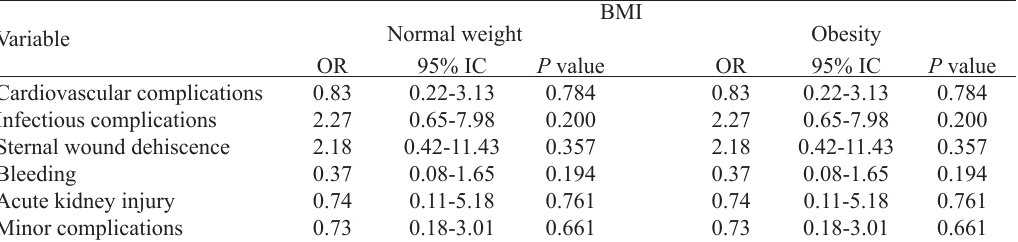
Table 5. Obesity and postoperative complications risk at CABG and/or valve replacement (multivariate analysis).